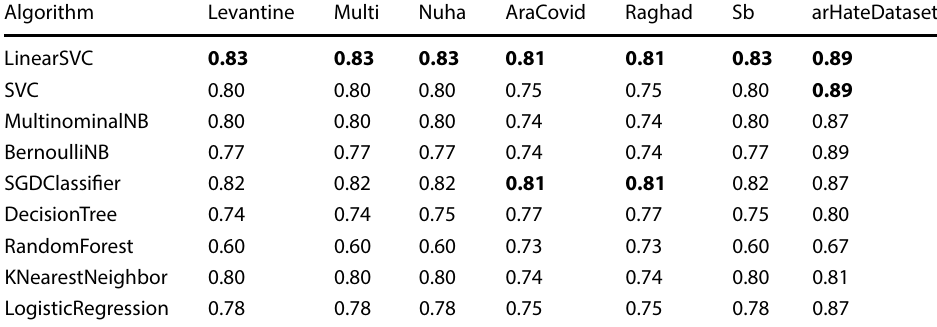
Table 4 Comparison of machine learning models in term of accuracy using all datasets